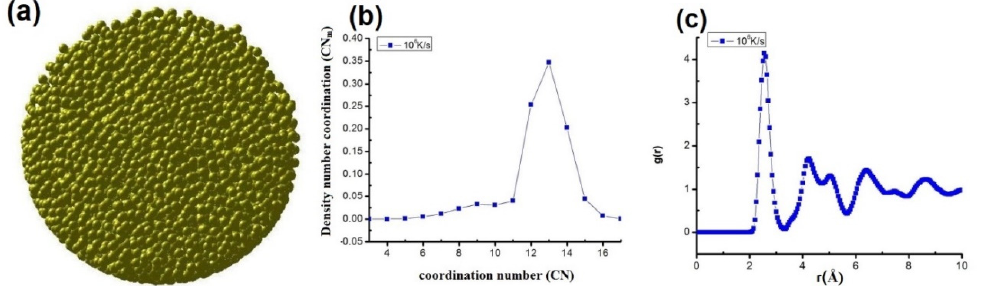
Figure 1. The shape ( a ), CNs ( b ), and RDF ( c ) of Ni 5324 ANPs with heating rate of 10 6 K/s at T = 300 K.